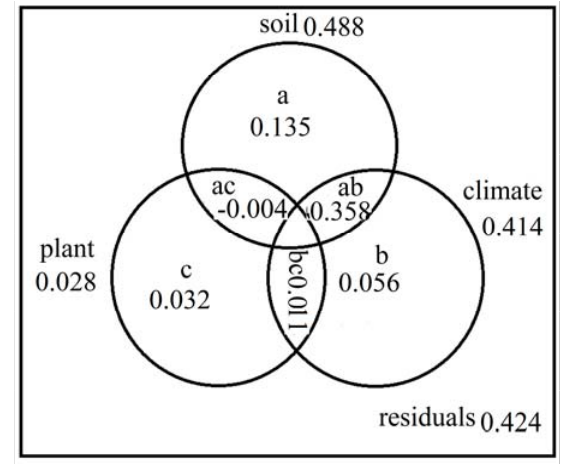
Figure 8. Variation partitioning of N transformations using the matrices of soil variables, plant variables and climate variables. Variables a, b and c denote the independent effects of soil, climate and plant, respectively. Variables ab, ac, bc denote the joint effects of soil and climate, soil and plant, climate and plant, respectively.